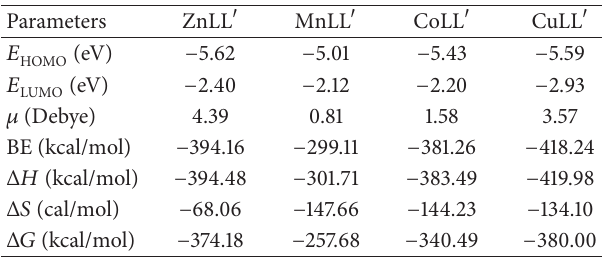
Table 2: a Some electronic and thermodynamic parameters of ZnLL 󸀠 , MnLL 󸀠 , CoLL 󸀠 , or CuLL 󸀠